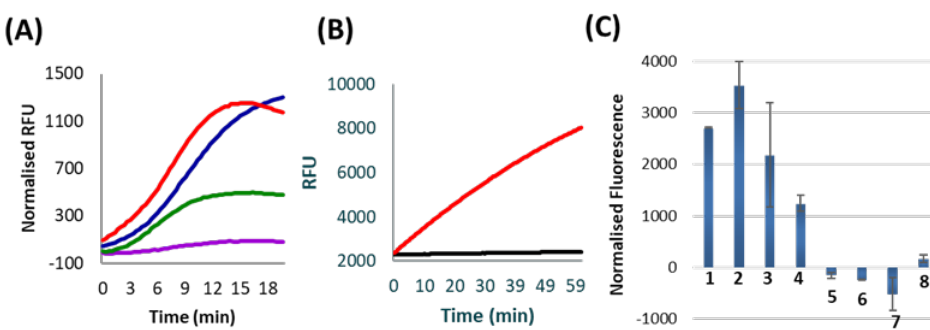
Figure 2. All data represent the average of two replicates. ( A ) Results from various rounds of Subzyme cross-catalysis. The product of an initial Subzyme-MP reaction was manually transferred through a series of reaction chambers containing alternating Subzyme-MPs for a total of seven rounds. The amount of active released DNAzyme was measured in separate reactions which contained labelled substrates after 1 (purple), 3 (green), 5 (blue) and 7 (red) rounds of incubation. Results are presented as normalized Relative Fluorescence Units (RFU) which is the fluorescence of no target controls (NTC) subtracted from the fluorescence of reactions containing target. ( B ) The results of an assay in which Subzyme-MPs are spatially confined within the boundaries of PMBs. Curves reflect substrate cleavage following incubation of PMB reactions containing (red line), or lacking (black line), initiating DNAzyme. Results are shown in raw RFU for 2.8 µm MP size and 0.8 µm polycarbonate PMB. ( C ) Results of a 30 min Subzyme feedback reaction using PMBs according to the schema presented in Figure 1B. Results are plotted as normalized fluorescence following a 20 min PMB incubation step and a 10 min fluorescence detection step. Reactions contain (1) C. trachomatis TNA (target), (2) 10 fM ompA target, (3) 2 fM ompA target, (4) 1 fM ompA target, (5) nuclease free water (NTC), (6) 1 nM PPIA off-target, (7) 1 nM p273 off-target and (8) Hu gDNA (off-target). Normalized fluorescence values were obtained for each reaction by subtracting the RFU at 0 min from the RFU at 10 min of incubation with fluorescent substrate.